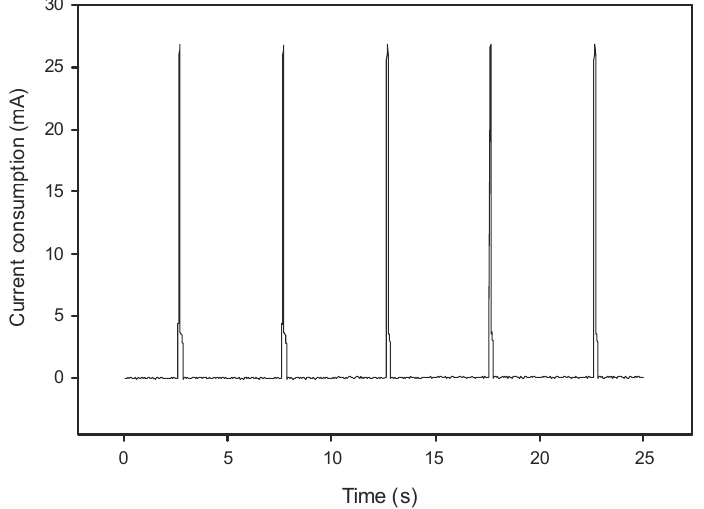
Figure 12. Power consumption of a low-power LTCC sensor over 25 s